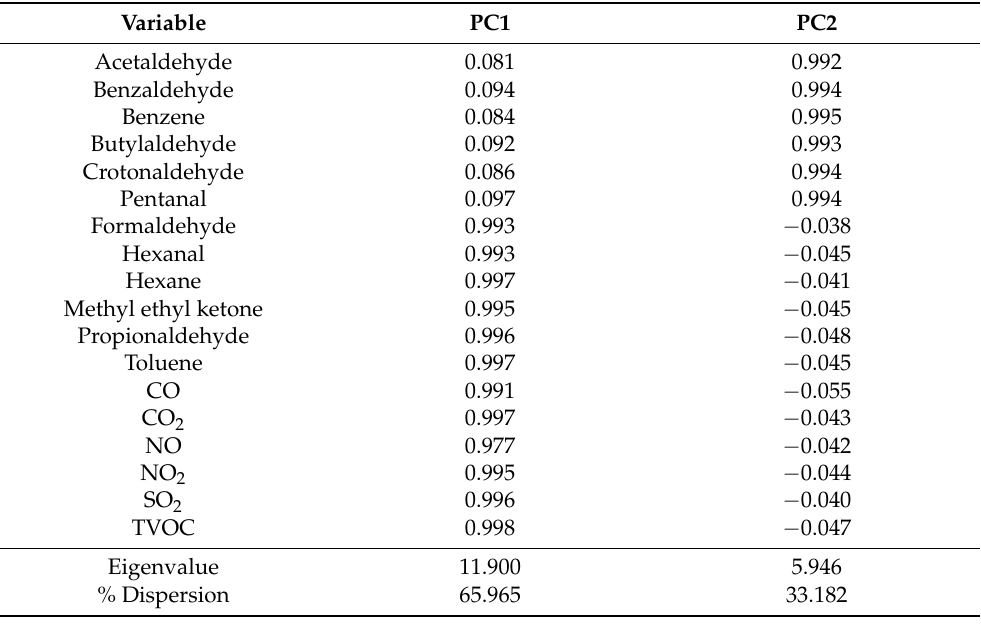
Table 7. Principal component (PC) analysis results. TVOC—total volatile organic compounds.